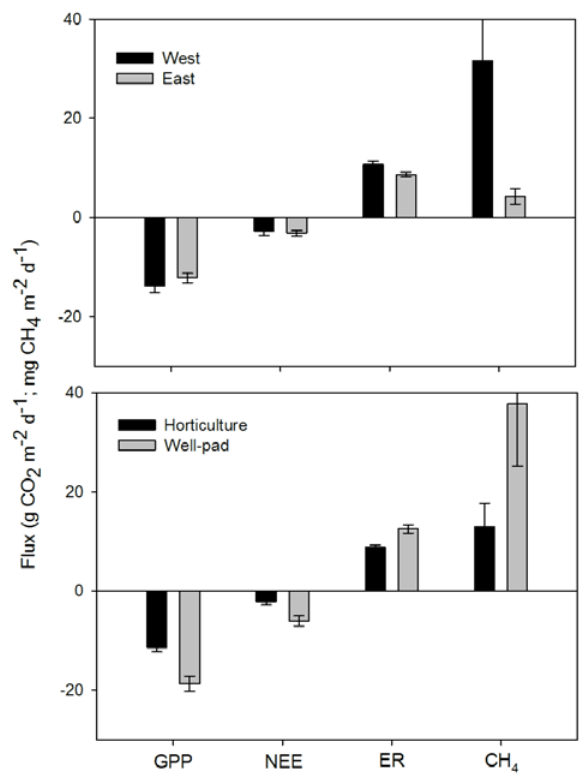
Figure 1. Top: Mean growing season gross primary production (GPP), ecosystem respiration (ER), net ecosystem CO 2 exchange (NEE); and bottom: methane (CH 4 ) flux (mg CH 4 m -2 d -1 ). GPP and NEE fluxes (g CO 2 m -2 d -1 )) when photon flux density of photosynthetically active radiation was greater than 1000 µmol m -2 s -1 . Error bars are standard errors. Negative values represent uptake by the ecosystem. Values are significantly different based on Tukey pairwise comparisons if they have no letters in common; letters should be compared only within one flux component. ERcorr and NEEcorr at natural was calculated by subtracting 3.25 g CO 2 m -2 d -1 from ER values